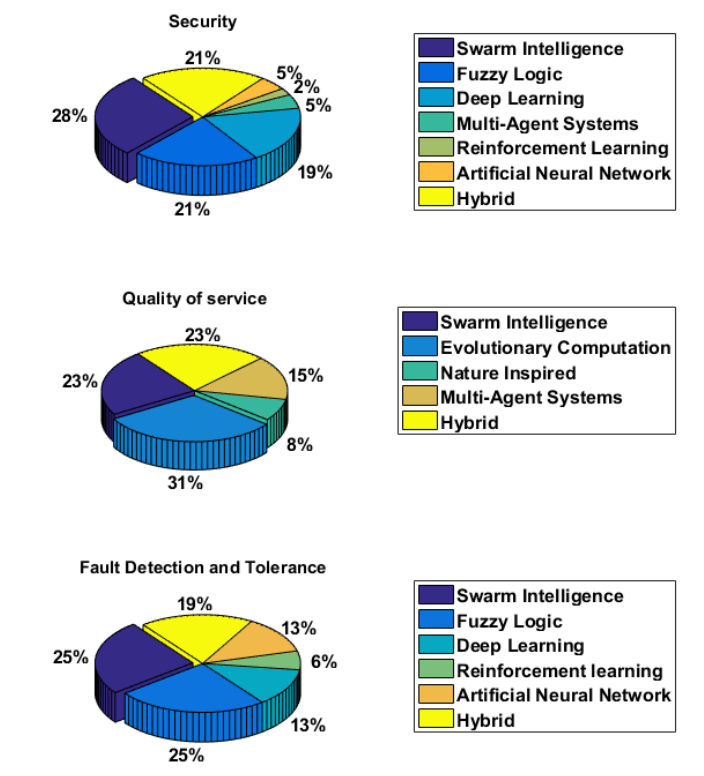
Figure 3. AI approaches in relation to different WSN